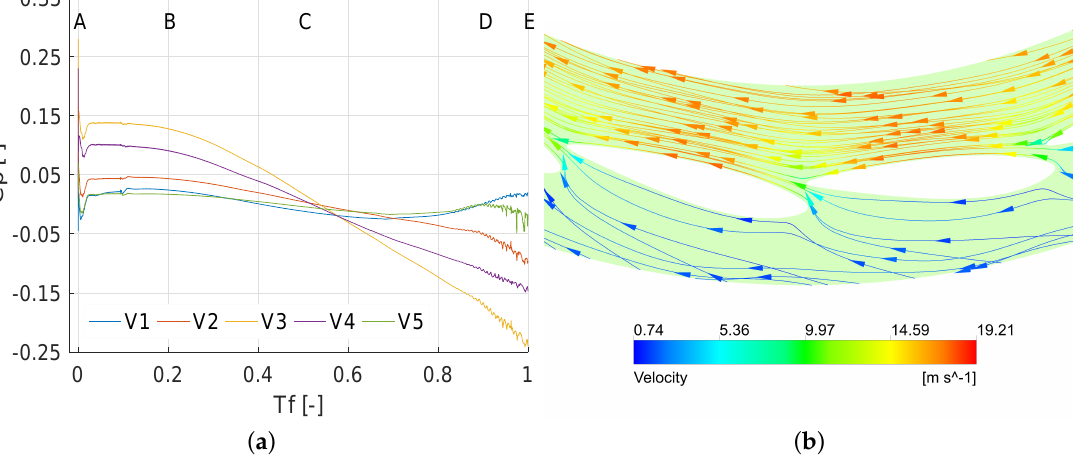
Figure 21. ( a ) Pressure coefficients of points on the guide vane1; and ( b ) detail of the streamlines of the vaneless spaces.